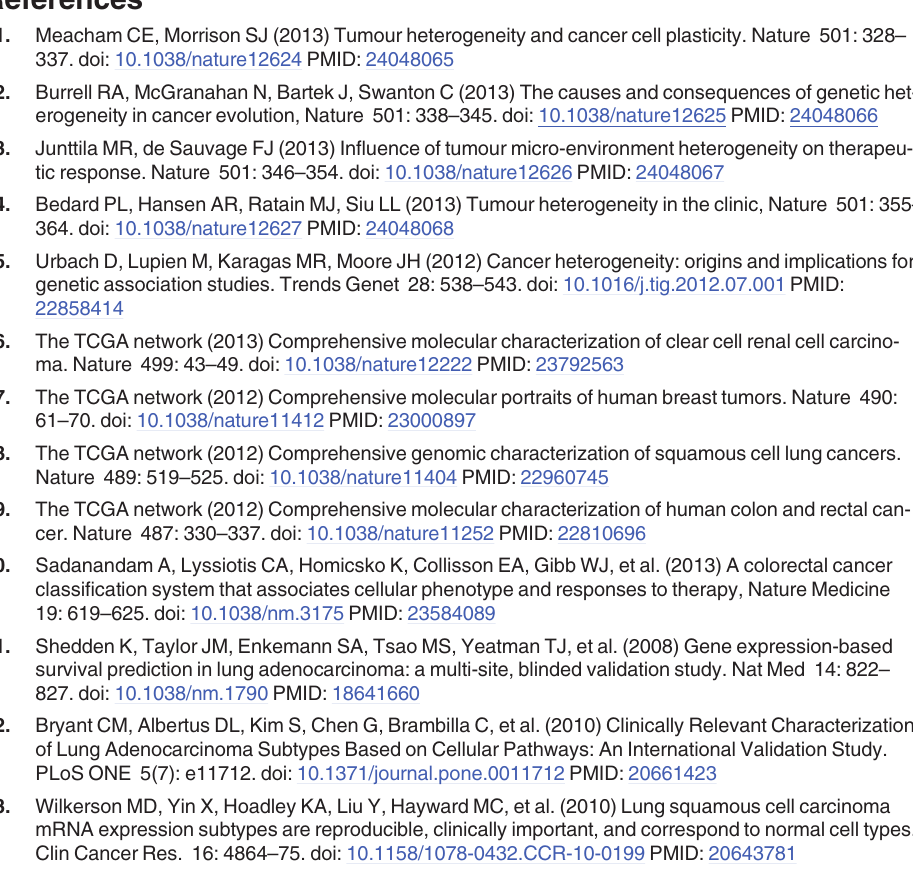
Table S2. Comparison of 3-year overall survival (%) of the patient grouping of different cluster- ing methods. Fig. S1. Comparison of the clusters in the literature and the clusters generated by MBI. Fig. S2. Comparison of sample grouping using matrix M vs matrix Y of the ACCstage1 dataset. Fig. S3. MBI helps identify “ noise or outlier ” sample from the gene expression